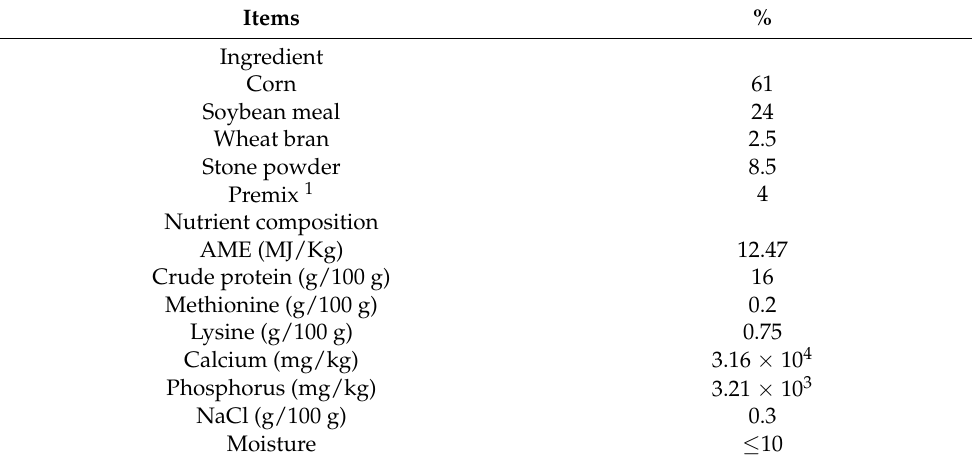
Table 1. Ingredients and composition of the basal diet. Items % Ingredient Corn 61 Soybean meal 24 Wheat bran 2.5 Stone powder